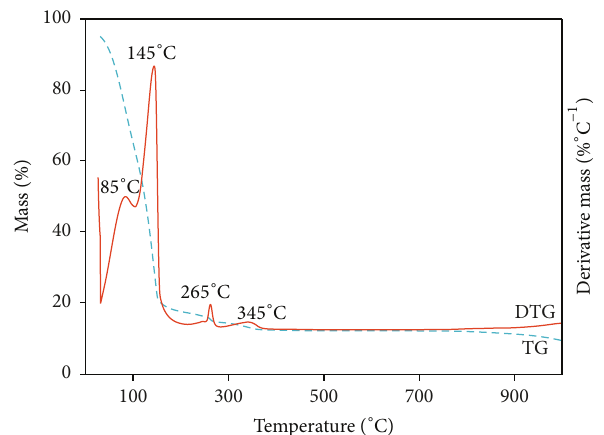
Figure 3: IES spectra of the gel sample heated at various tempera-